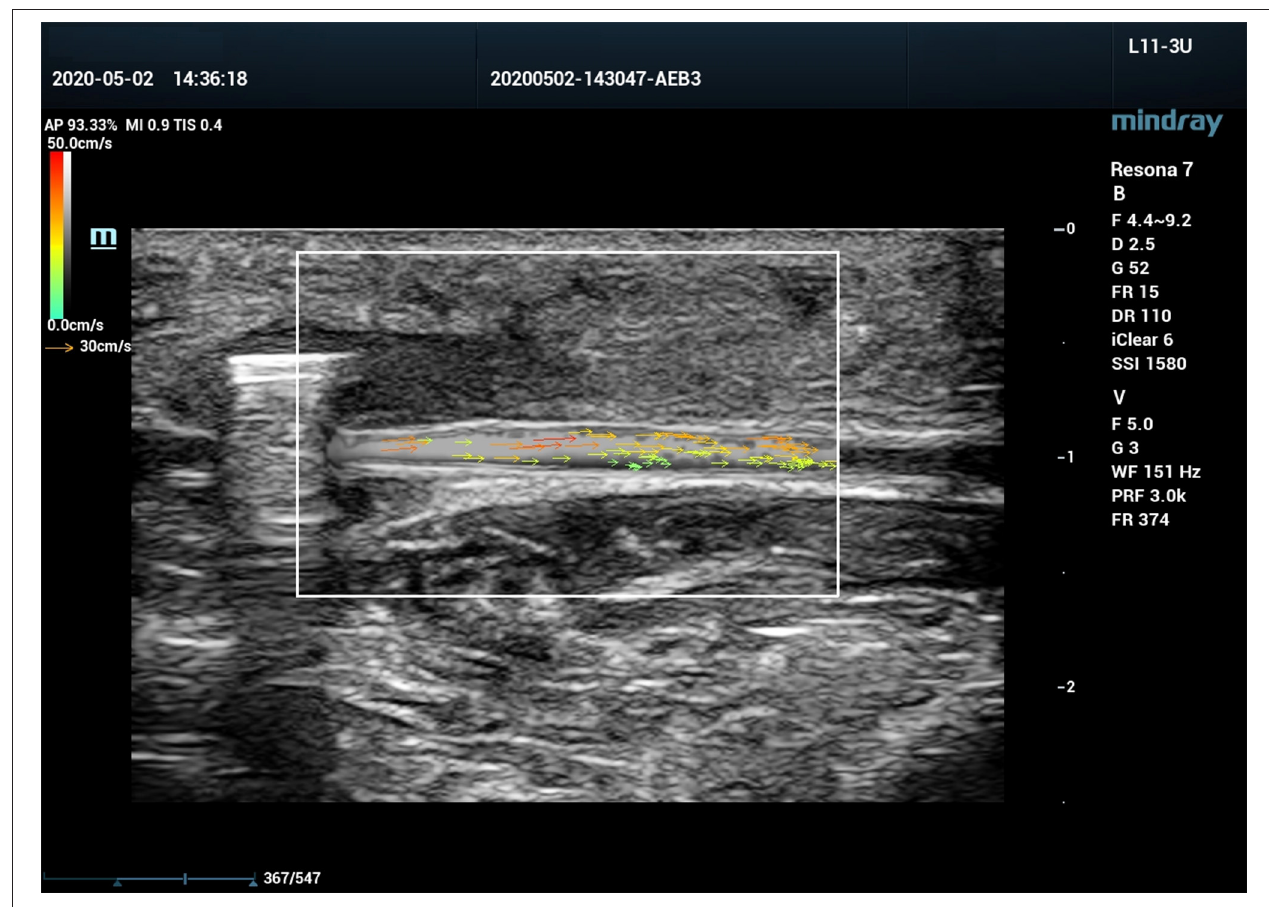
FIGURE 5 | V Flow ultrasound image of a canine femoral artery with post-stenotic segment